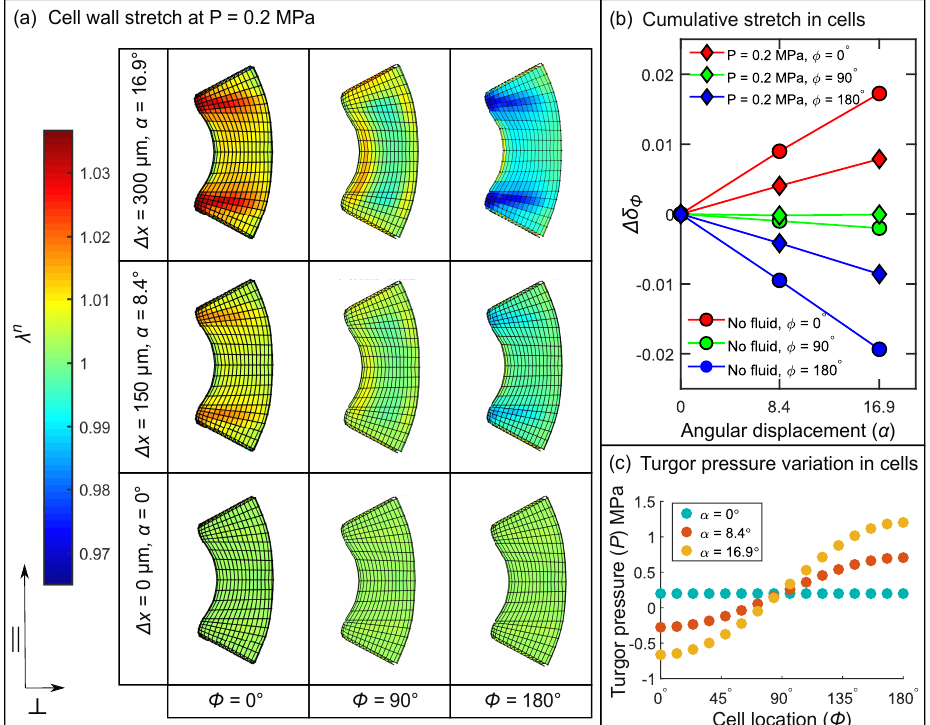
Figure 8. ( a ) Stretch λ n in the elements of the sensory cells located at ( φ = 0 ○ ,90 ○ ,180 ○ ) shown for 3 angular displacements α . ( b ) Change in cumulative area-normalized stretch ∆ δ φ for cells located at φ = 0 ○ ( red ), φ = 90 ○ ( green ) and φ = 180 ○ ( blue ) with increasing angular displacement α for cells with fluid ( diamonds ) and without fluid ( circles ). ( c ) Variation of fluid cavity pressure P in the 16 sensory cells at 3 stages of deflection α = 0 ○ ( blue ), α = 8.4 ○ ( red ), and 16.9 ○ ( yellow